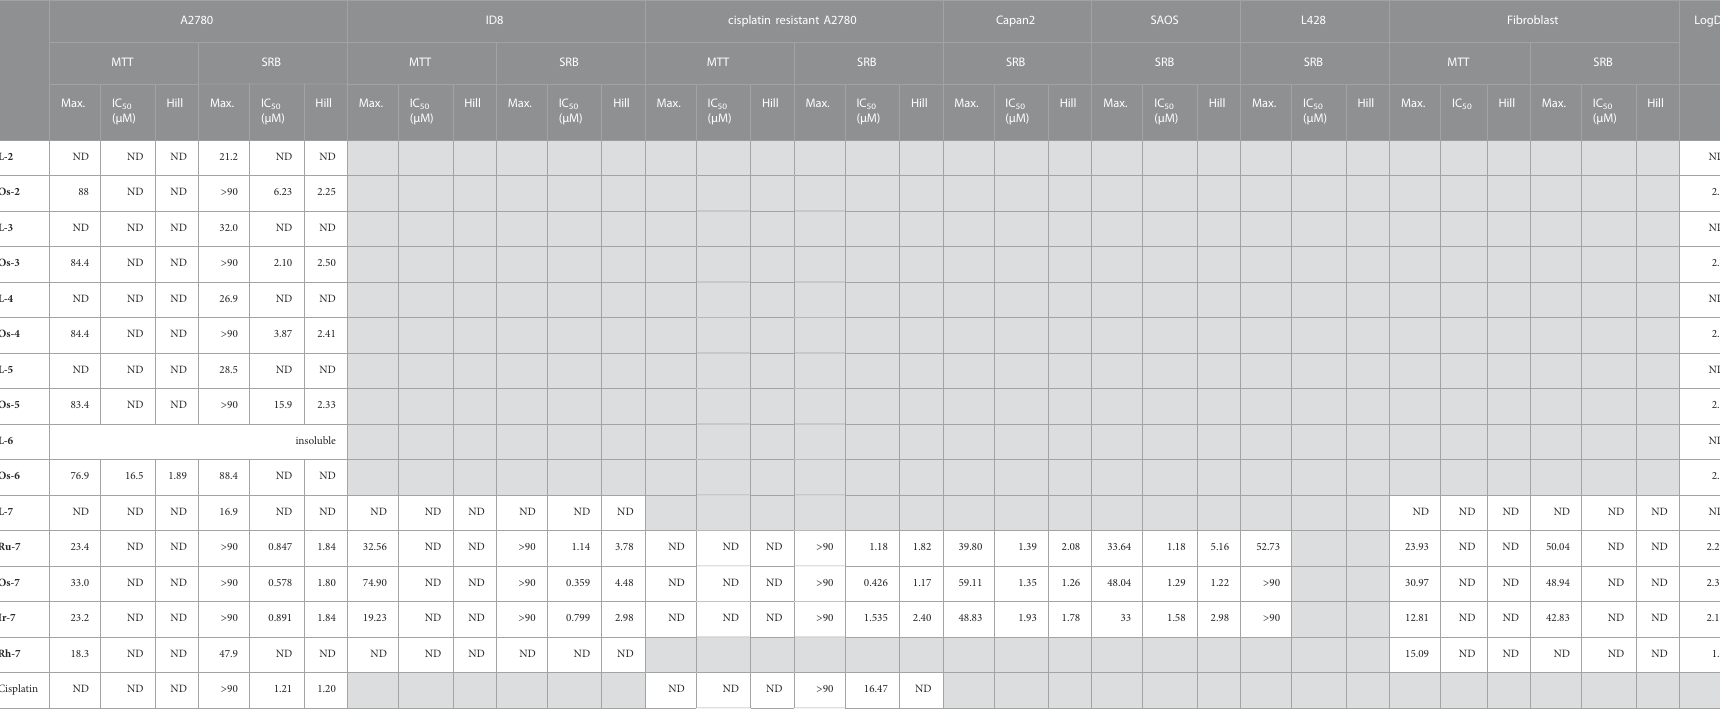
TABLE 2 Numeric values characterizing the complexes assessed in this study. The IC 50 value of cisplatin was obtained from (Kacsir et al., 2021). Max — Maximal inhibition in %, ND — not